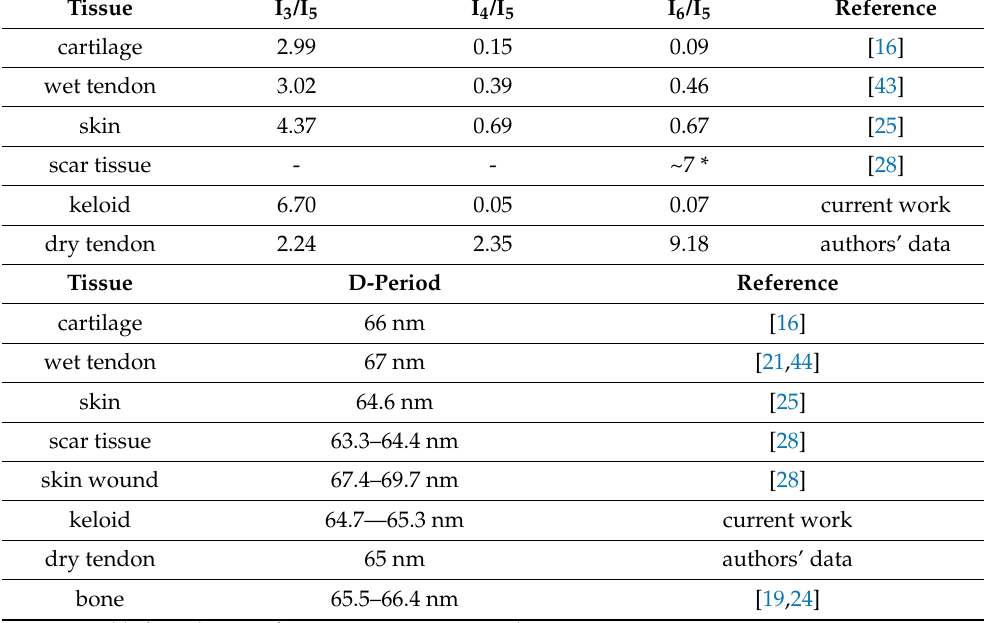
Table 1. Top: meridional peak intensity ratios (odd/odd: (I3/I5), and even/odd: (I4/I5) and (I6/I5)) for several connective tissues taken from the literature, and keloid tissue from the current work. Bottom: comparison of native D-period of the same set of tissues (with bone added) to keloid tissue. Tissue I 3 /I